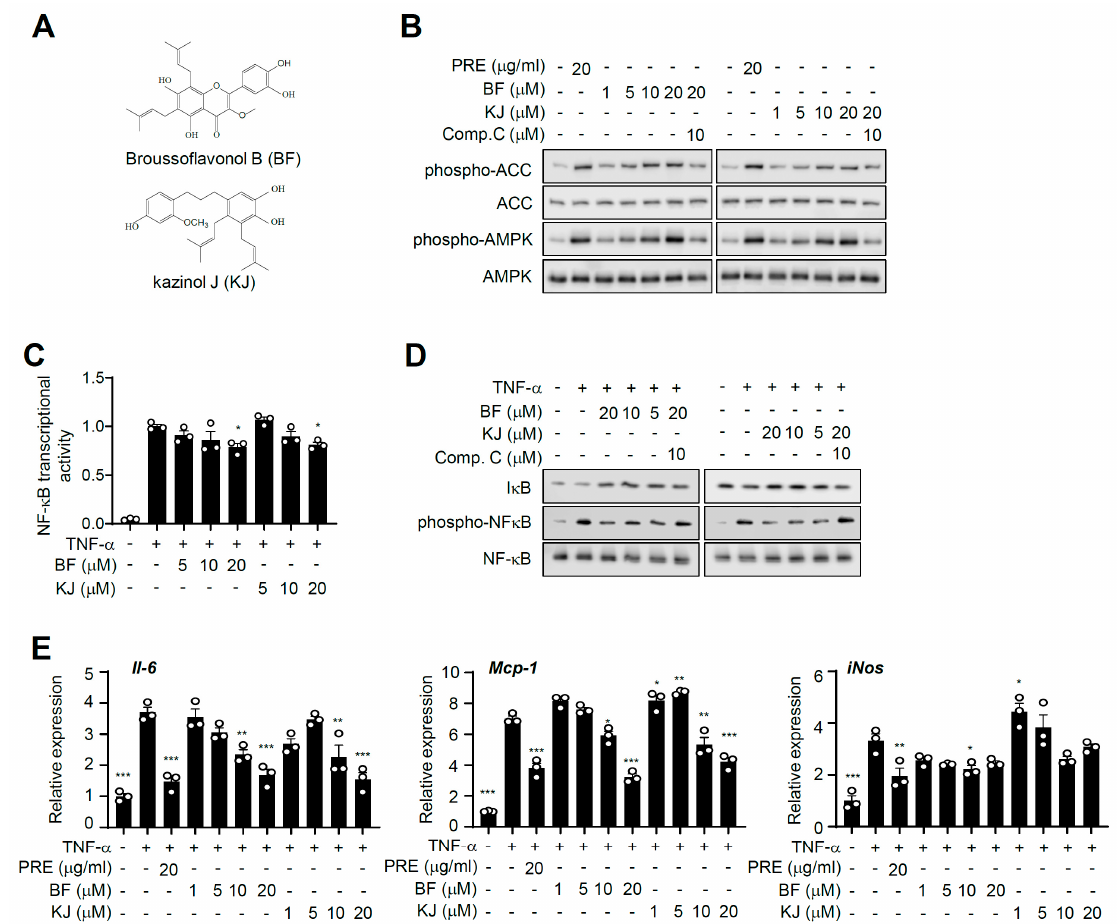
Figure 6. Broussoflavonol B (BF) and kazinol J (KJ) are bioactive compounds of PRE. ( A ) Chemical structure of Broussoflavonol B (top) and kazinol J (bottom). ( B ) 3T3-L1 adipocytes were pre-incubated with / without compound C (10 µ M) for 1 h, and then, cells were treated with BF or KJ for an additional 2 h. The expression of phospho-AMPK, AMPK, phospho-ACC, and ACC was analyzed by Western blotting. ( C ) HEK-293 cells were transfected with the NF- κ B-responsive luciferase reporter and pRL-Renilla. The cells were treated with BF and KJ as the indicated concentration for 24 h, followed by treatment with TNF- α (10 ng / mL) for an additional 6 h. The cells were harvested, and luciferase activity was measured. Data are shown as the mean ± S.E.M. ( n = 3) * p < 0.05; ** p < 0.001; *** p < 0.0001 vs. the TNF- α -only-treated group. ( D ) After 3T3-L1 adipocytes were pretreated with / without compound C, cells were incubated with / without BF or KJ for 24 h and stimulated with TNF- α (20 ng / mL) for 30 min. The expressions of phospho-I κ B, I κ B, phospho-NF- κ B, NF- κ B, and tubulin were analyzed by Western blotting. ( E ) 3T3-L1 adipocytes were pre-incubated with the indicated concentration of BF or KJ for 24 h, followed by treatment with 20 ng / mL TNF- α for 5 h. Total RNA was isolated, and the mRNA expression level of each gene was analyzed by quantitative real-time PCR. Data are shown as the mean ± S.E.M. ( n = 3) * p < 0.05; ** p < 0.001; *** p < 0.0001 vs. the TNF- α -only-treated group.